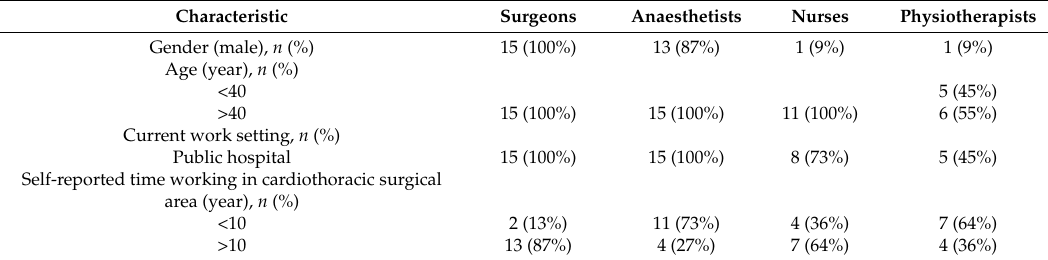
Table 1. Characteristics of the participating clinicians ( n =